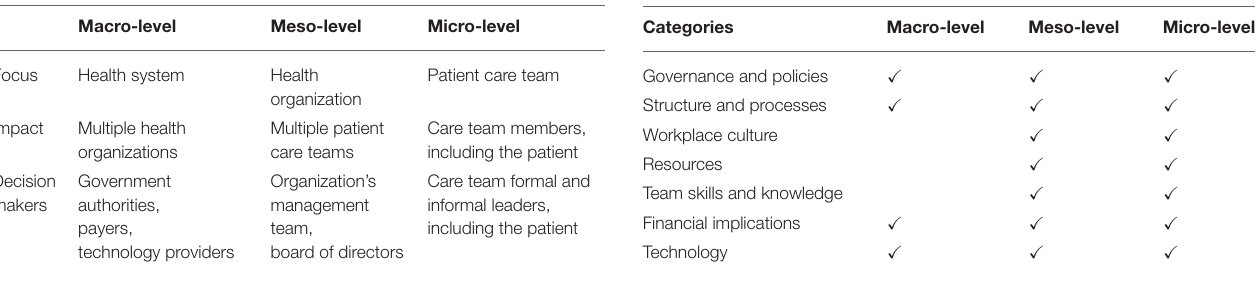
TABLE 2 | Levels of analysis. TABLE 3 | Organizational factors categories according to level of